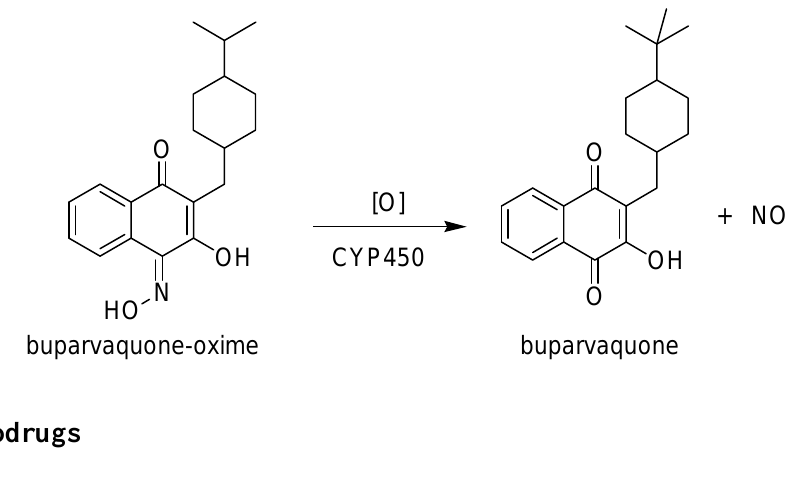
Figure 12. The conversion of buparvaquone-oxime into buparvaquone by enzymatic oxidation and release of